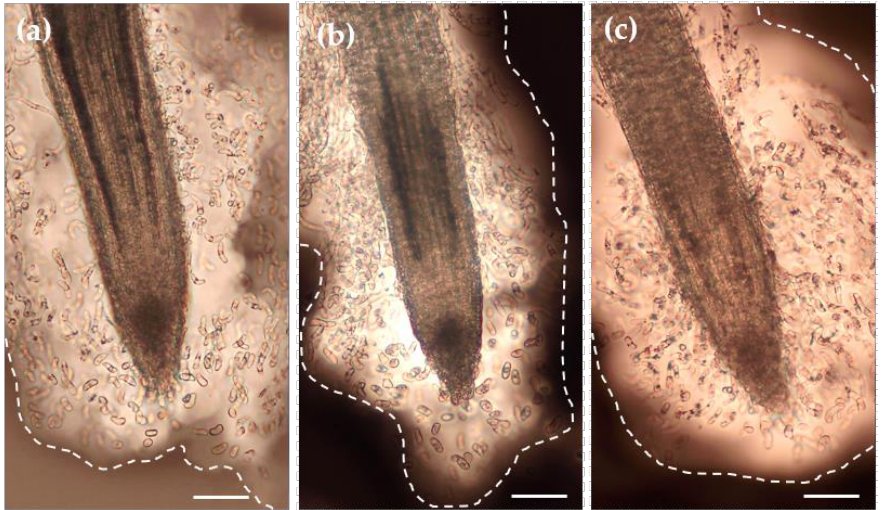
Figure 3. Microscopic observation of the RET of root tips of the control ( a ) and stressed ( b , c , PEG25 and PEG50, respectively) seedlings using India ink contrast staining. Root tips were collected on day 6 after 72 h of osmotic stress. The images show a significant amount of mucilage (delimited by the dotted line) embedding AC-DCs. Bar scale: 100 μm.